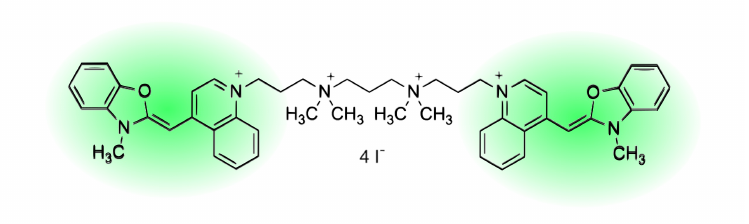
Figure 1. Structure of YOYO-1 molecule. Fluorescent groups of the molecule marked with green areas.